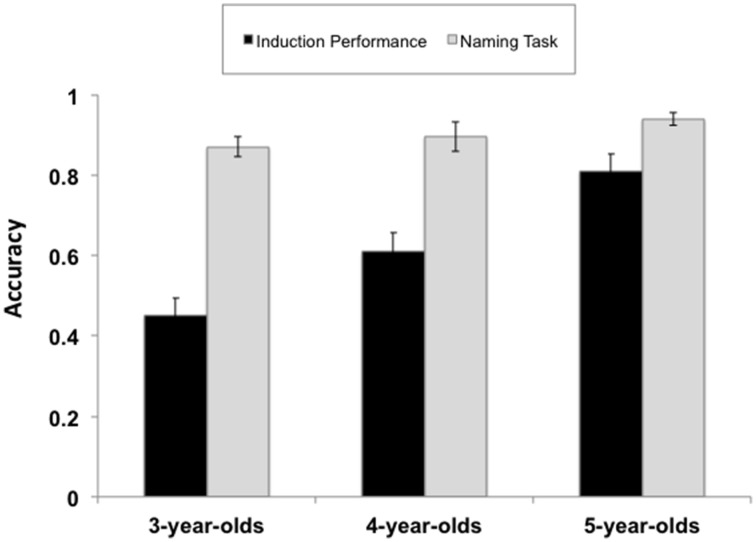
Summary of children's performance on the Property Induction Task and the Naming Task across age groups. Error bars represent the standard errors of the mean.